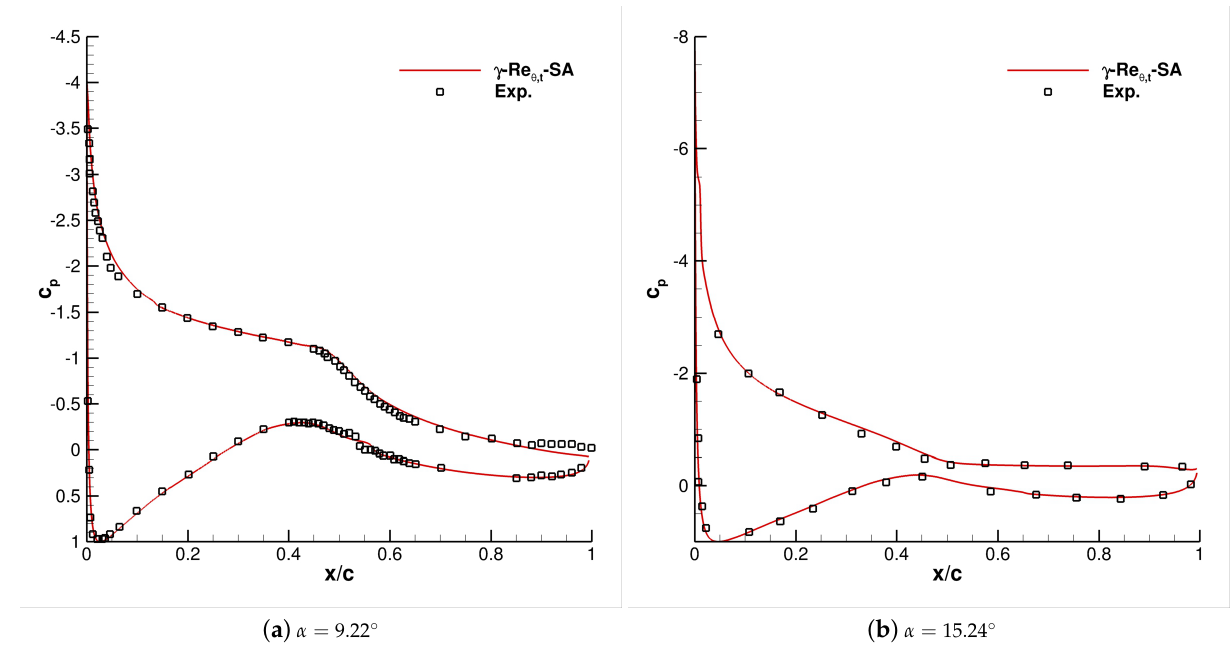
Figure 8. S809, Re = 2 × 10 6 . Pressure coefficients.